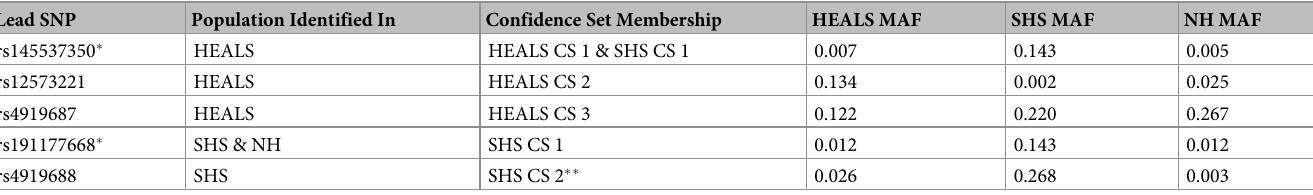
Table 3. Minor Allele Frequency (MAF) comparison of lead signals across arsenic-exposed cohorts. Lead